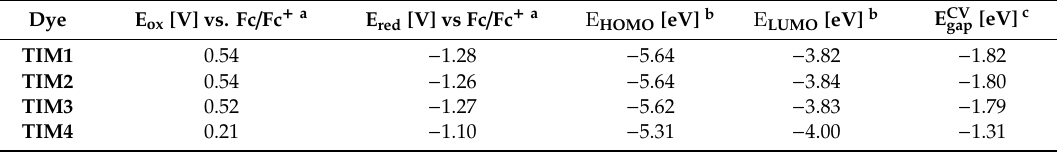
Table 2. Electrochemical properties of the dyes TIM1–4 in DMF